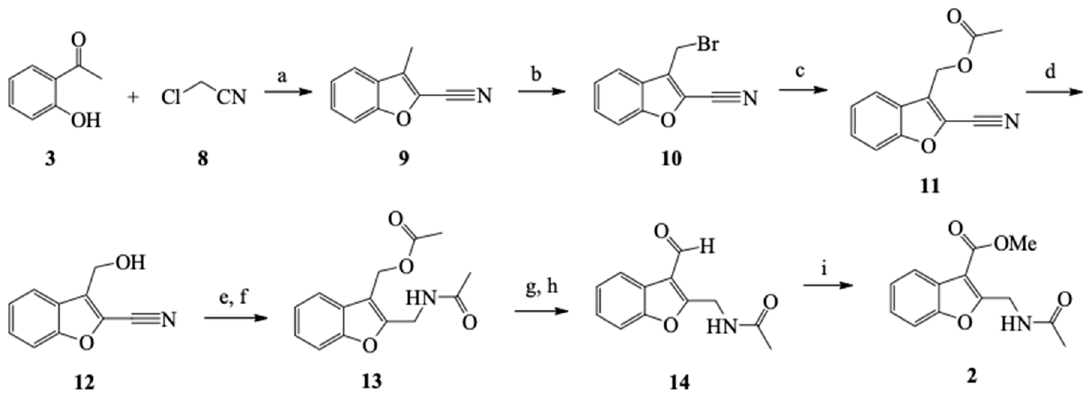
Scheme 4. General synthetic pathway for preparing compound 2 . Reaction conditions: (a)